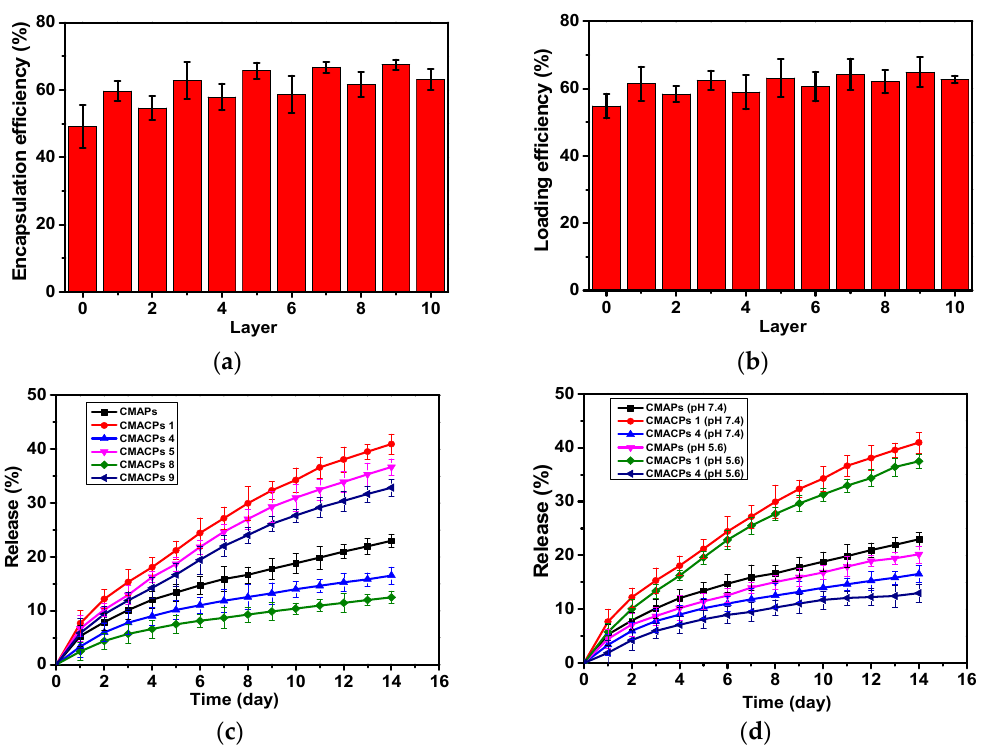
Figure 5. The drug loading and release profiles of the CMAPs and CMACPs are affected by the type of outermost polymers and the number of layers. Encapsulation efficiency of CMAPs and CMACPs ( a ). Curcumin loading efficiency into CMAPs and CMACPs ( b ). Curcumin release profile of CMAPs and CMACPs with different layers (1, 4, 5, 8, 9) of deposited polymers ( c ). Curcumin release profile of CMAPs and CMACPs (layer number: 1 and 4) in PBS buffer at pH 7.4 and pH 5.6 ( d ). The results are shown in mean ± SD, n = 3.